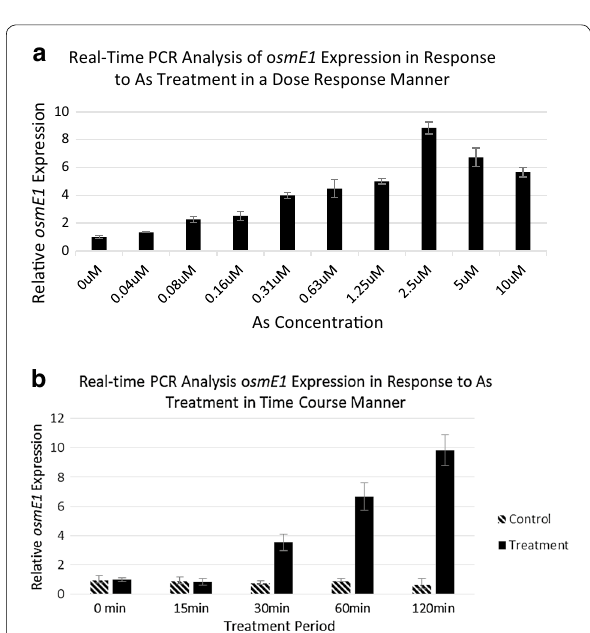
Fig. 6 Quantitative analysis of osmE1 gene expression with RT-PCR. DH5α were treated with 0, 0.04, 0.08, 0.16, 0.31, 0.63, 1.25, 2.5, 5, and 10 μM arsenite for 2 h ( a ) or with 2.5 μM arsensite for 0, 15, 30, 60, and 120 min ( b ). RNA was isolated from DH5α and reverse transcribed to cDNA with AMV. Real-time PCR with SYBR green was performed